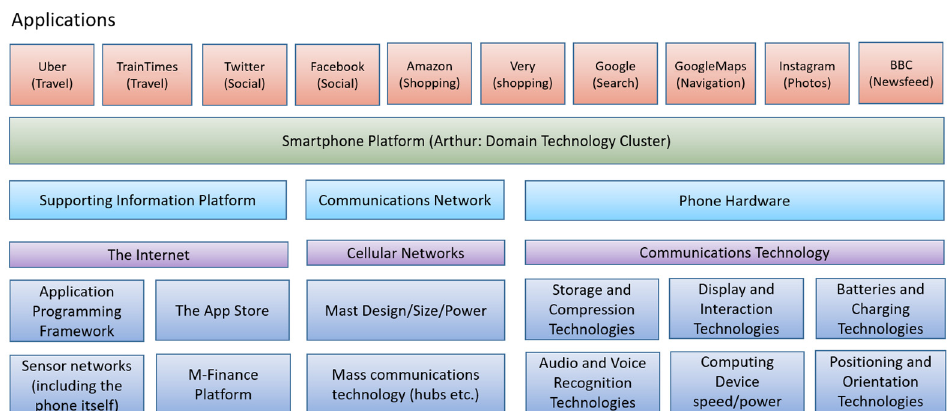
Figure 1. Arthur’s concept of the technology eco-system, Brackin et al. (2019) [16].